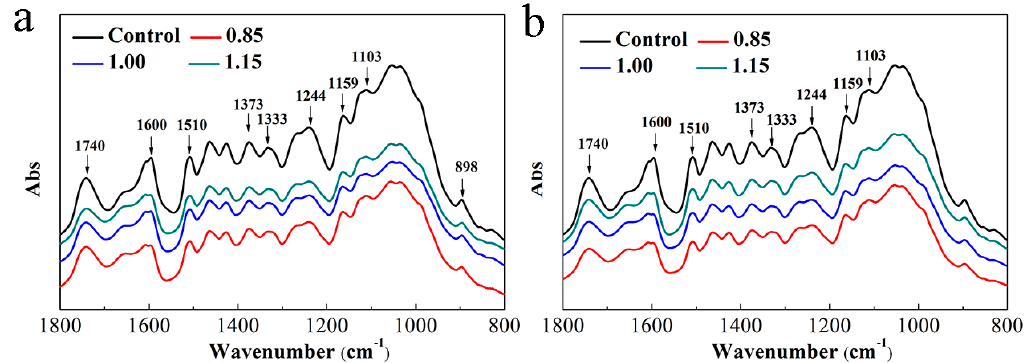
Figure 6. FTIR spectra of healthy (control) and decayed OWMEC samples with different densities: ( a ) T. versicolor decay; ( b ) G. trabeum